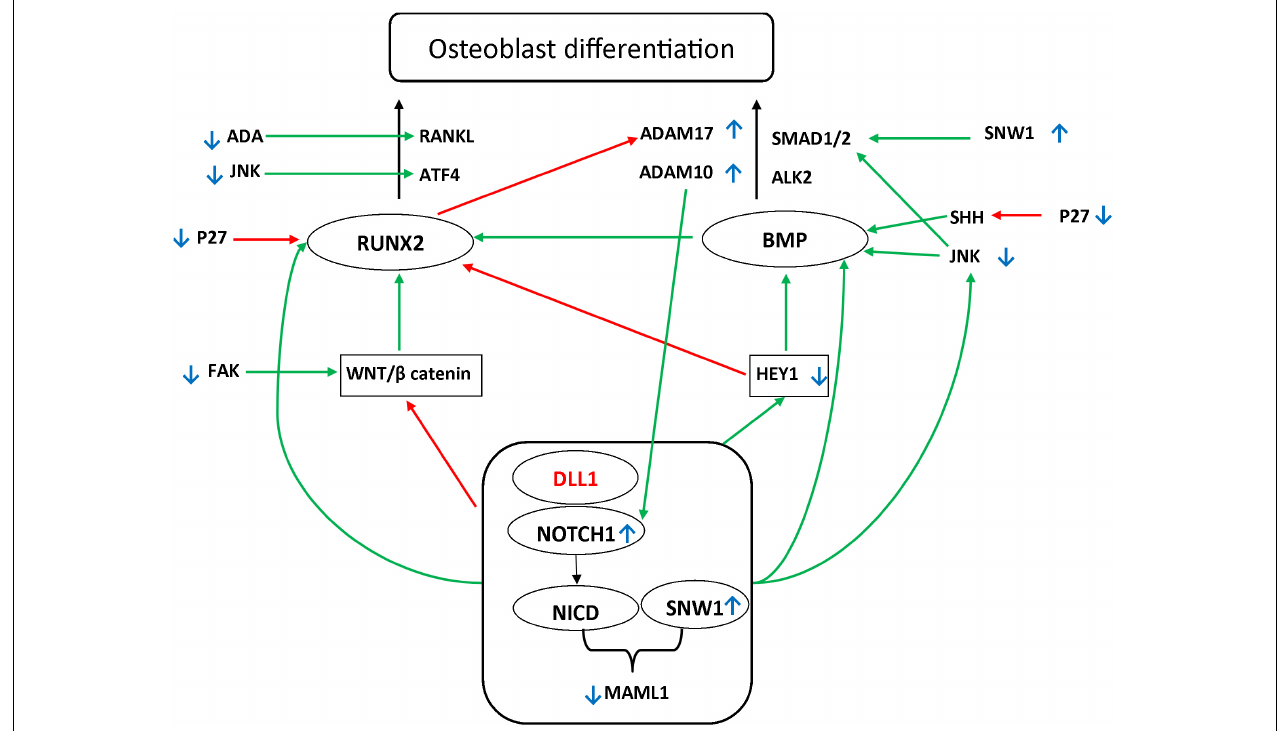
FIGURE 1 | Possible pathways underlying the DLL1/Notch signaling pathway defect. Two main pathways have been shown to be involved in osteoblast differentiation: Runt-Related Transcription Factor 2 (RUNX2) (OMIM 600211)/Receptor Activator of NF-kappa- β Ligand (RANKL) (OMIM 602642) and TGF β Bone morphogenetic protein (BMP). Mothers against decapentaplegic homolog (SMAD) further activates the RUNX2. BMP2 (OMIM 112261) and BMP9 (OMIM 605120) are major regulatory factors in (Date et al., 2004; Sharff et al., 2009) modulating the osteogenic differentiation of bone mesenchymal stem cells, advancing mineralization, increasing adherence, and facilitating the activation and expression of several markers associated with osteogenesis (Sun et al., 2015). Among the main regulators affecting these pathways are WNT/ β -catenin and HEY1/2 (OMIM 602953 and 604674, respectively). It has been reported that RUNX2 is upregulated by the WNT/ β -catenin pathway. Moreover, it has been shown that RUNX2 is downregulated by the Notch signaling pathway. Alternatively, Notch upregulates hairy-and-enhancer-of-split-1–7 (HES1–7) and HEY1/2. These play a regulatory role downstream in the process by activating BMP, in addition to the negative feedback on RUNX2 (Sharff et al., 2009; Zeng et al., 2015; Wang et al., 2016). The Notch signaling pathway further orchestrates the process of osteoblast differentiation through direct upregulation of RUNX2, BMP, and JNK, which activate the SMAD1 receptor by phosphorylating the linker region (Swiatek et al., 1994; Zamurovic et al., 2004; Canalis et al., 2014; Li et al., 2015; Cao et al., 2017; Kibe et al., 2018). Green arrows indicate the upregulation of the targets. Red arrows indicate the downregulation of the targets. Small blue, up and down arrows reflect the results in the affected